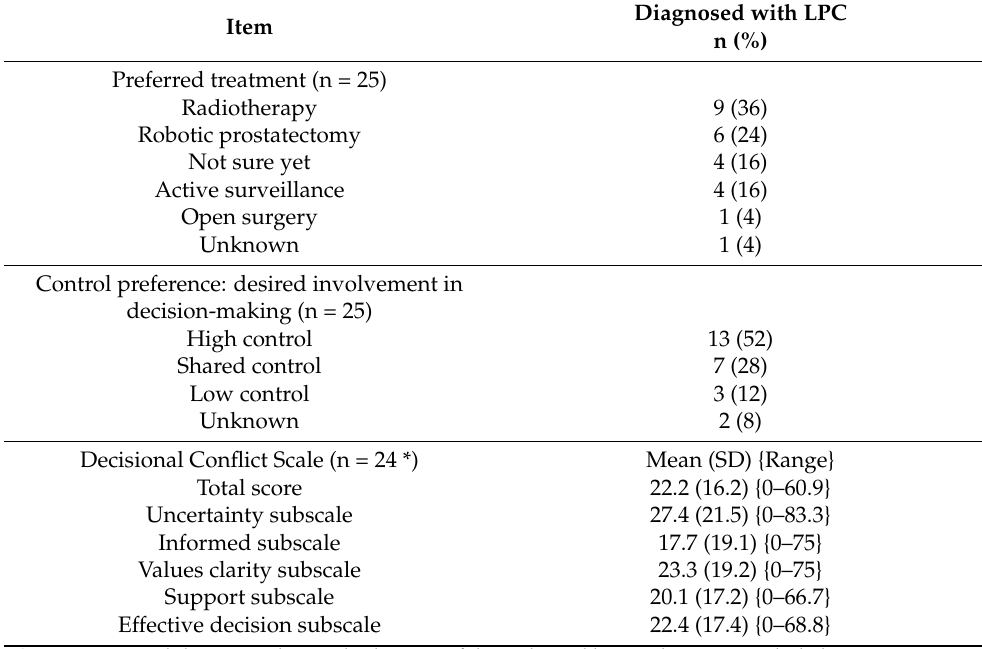
Table 4. Decisional